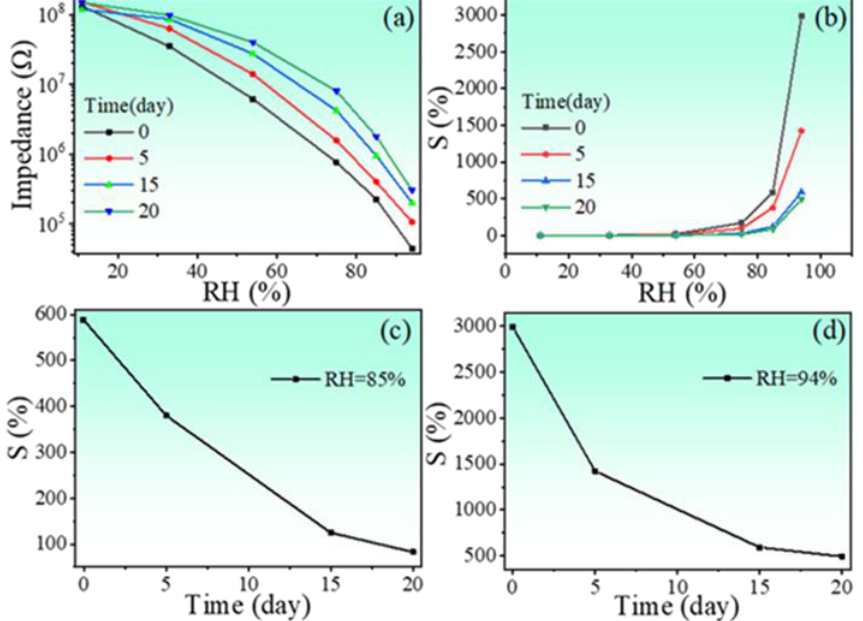
Figure 9. Variations in sensor impedance ( a ) and sensitivity ( b ) relative to humidity for different time intervals; Variations in sensor sensitivity with time at 85 ( c ) and 94%RH ( d ).